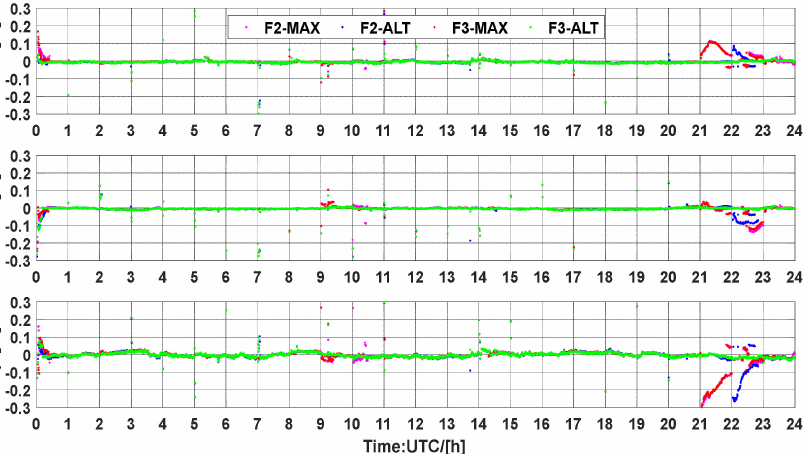
Figure 18. Position errors for UCPPP PAR using the atmospheric corrections from BRUX station on DOY 082,